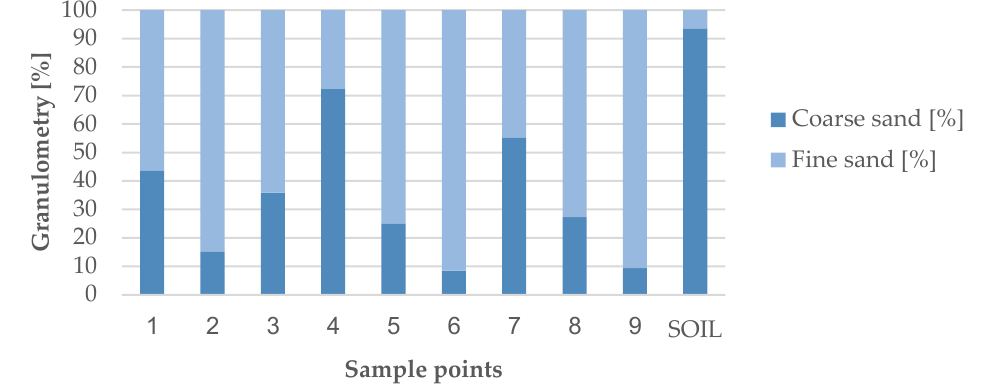
mining area [%]. Figure 8. Variation in coarse and fine sand in the samples, Băiuț mining area [%] . ,